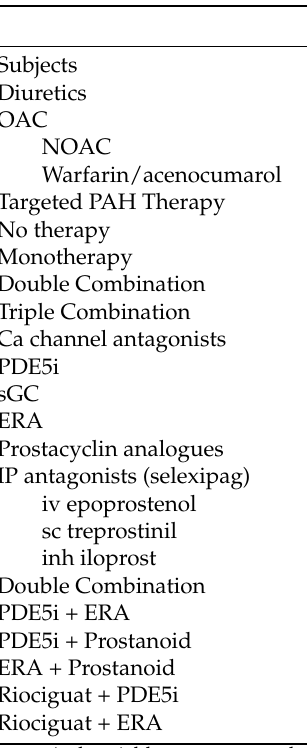
Table 4. Baseline Supportive and Targeted-PAH